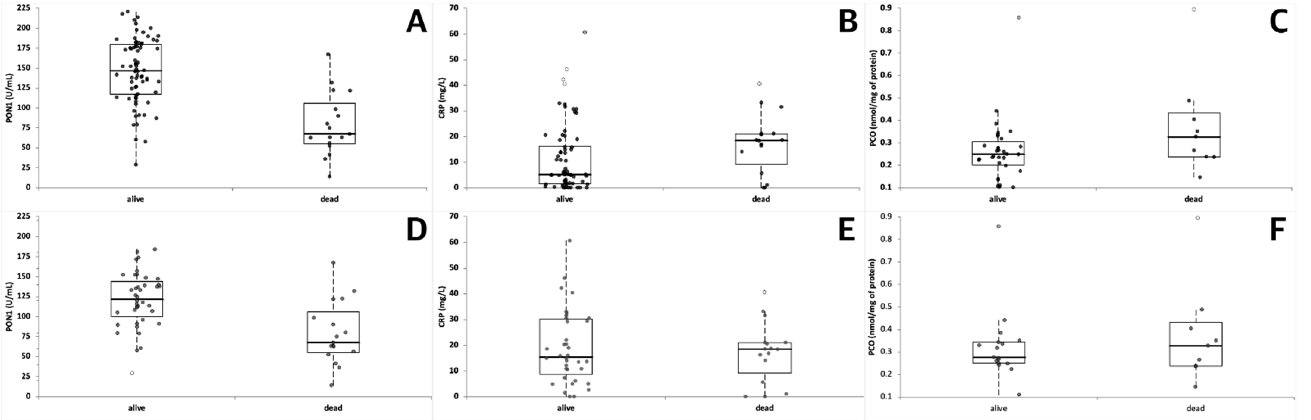
Figure 4. Serum activity of PON1 ( A , D ) and concentration of CRP ( B , E ) and PCO ( C , F ) in dogs that survived or died during the follow up. The analysis was performed either on the whole caseload (upper graphs) or after exclusion of clinically healthy dogs (lower graphs). The boxes indicate the I-III interquartile range (IQR), the horizontal black line indicates the median values, whiskers extend to further observation within quartile I minus 1.5 × IQR or to further observation within quartile III plus 1.5 × IQR. Black dots indicate the results that are not classified as outliers. White dots indicate near outliers (values exceeding the third quartile ± (1.5 × IQR)), and grey dots indicate far outliers (values exceeding the third quartile ± (3.0 × IQR)).